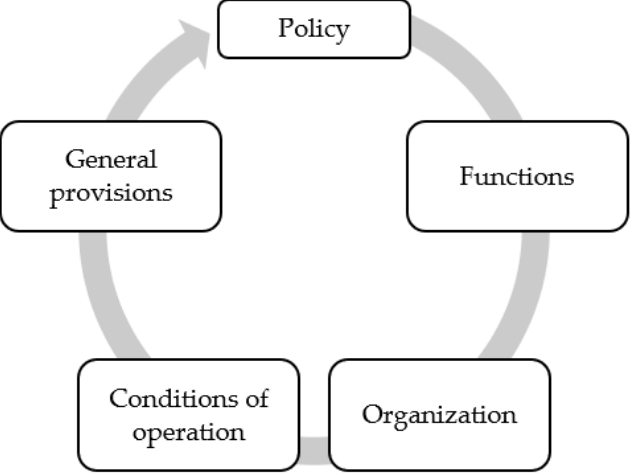
Figure 2. Situational analysis following the ILO C161 Convention.